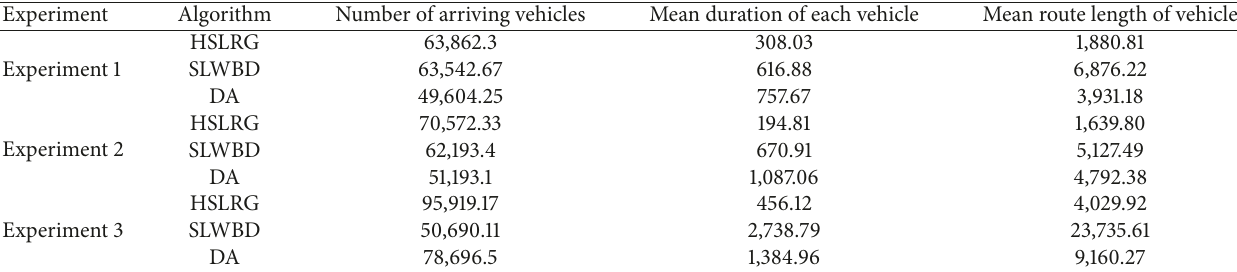
Table 3: Results of Experiments.